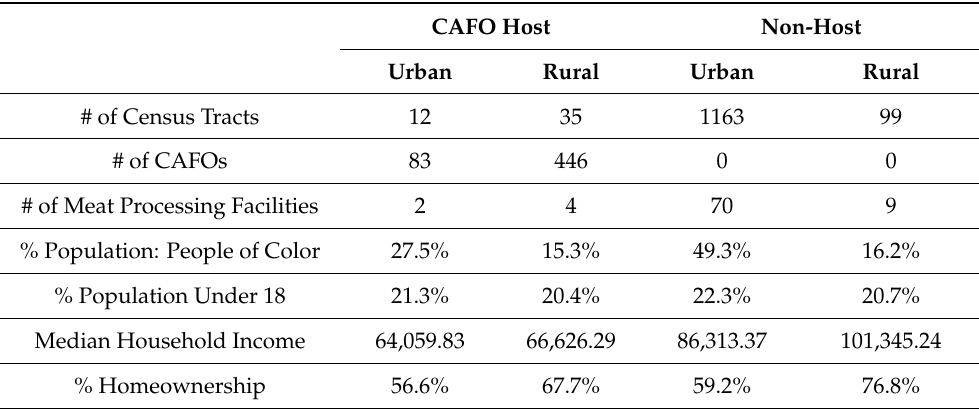
Table 1. Distribution of Features/Sociodemographic Features, CAFO Host vs. Non-Host. CAFO Host Non-Host Urban Rural Urban Rural # of Census Tracts 12 35 1163 99 # of CAFOs 83 446 0 0 2 4 70 9